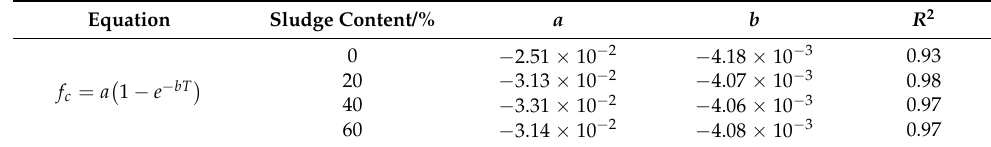
Table 4. Fitting results of water absorption rate as a function of temperature.